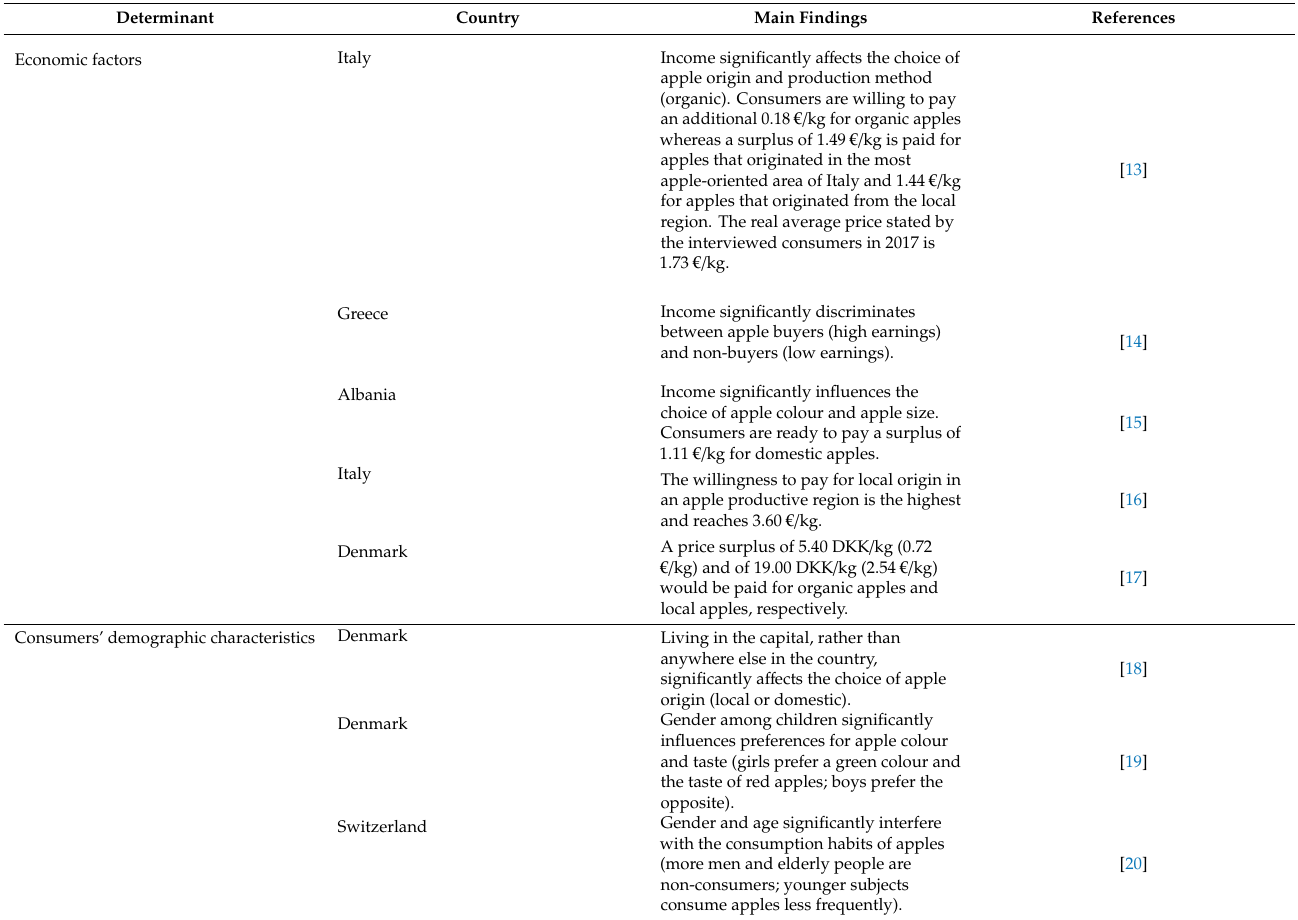
Table 1. Literature review—main determinants of apple